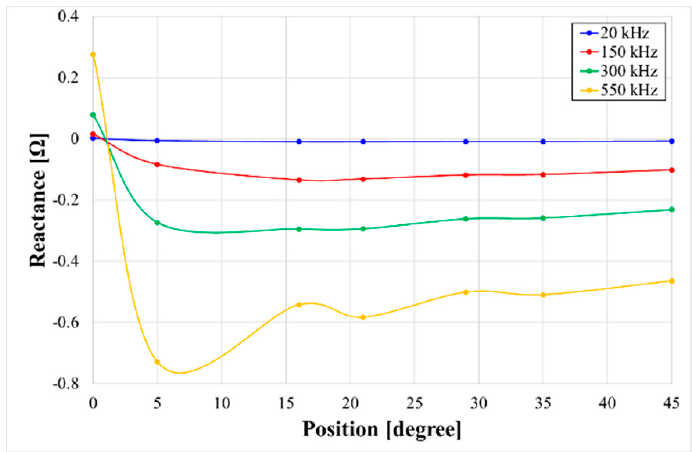
Figure 9. Comparison of reactance by coil position and CSA (Cross Sectional Area) variation.